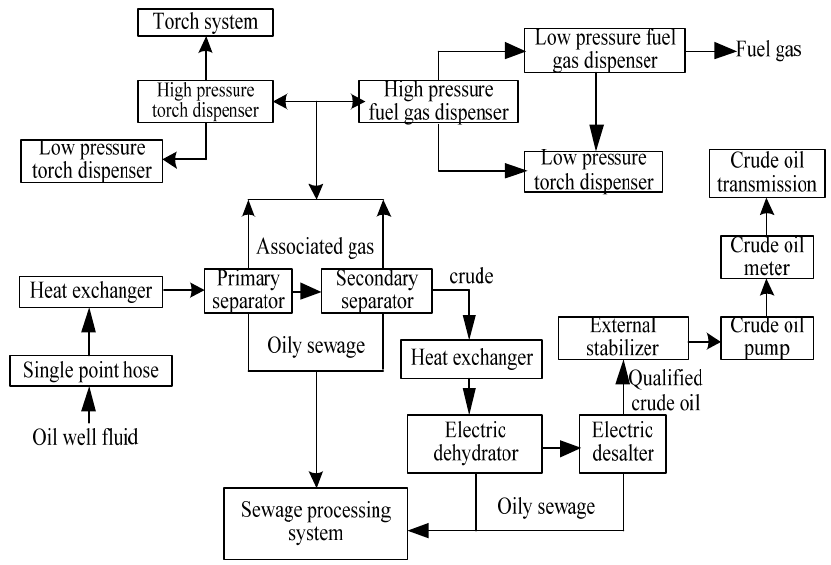
Figure 1. The processing technology flow diagram of floating production storage and offloading system (FPSO) oil and gas processing system.